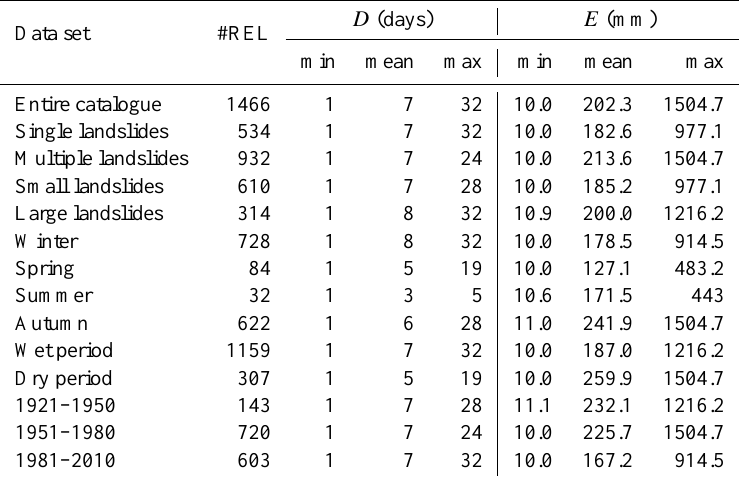
Figure 2e shows the number of REL per municipality. The average number of REL in a municipality is four, the min- imum is zero (95 municipalities, located chiefly in the N part of the region and along the SW coast), and the max- imum is 47, in the Catanzaro municipality (Fig. 2e). More than 30 municipalities experienced 10 or more REL in the investigated period. Figure 2f portrays the number of REL per year. On average, 16 REL occurred every year with a maximum of 139 REL in 1973. The 3 days with the largest number of REL were 18 February 2010 (39 REL), 29 Febru- ary 1956 (33), and 27 November 1959 (30). The month with the largest number of REL was January (337), followed by November (255), and February (254). The decades with the largest number of REL were those between 1950 and 1959, between 1970 and 1979, and between 2000 and 2009. In- spection of the cumulated number of REL (black curve in Fig. 2f) reveals that in the early period 1910–1950, the rate of the REL is lower than in the later period 1950–2010. This is a result of the different completeness of the information of the LE (Fig. 2b). Figure 3b shows the number of REL per year in the 90- (78), 1954 (76), and 1996 (72). The average value (16